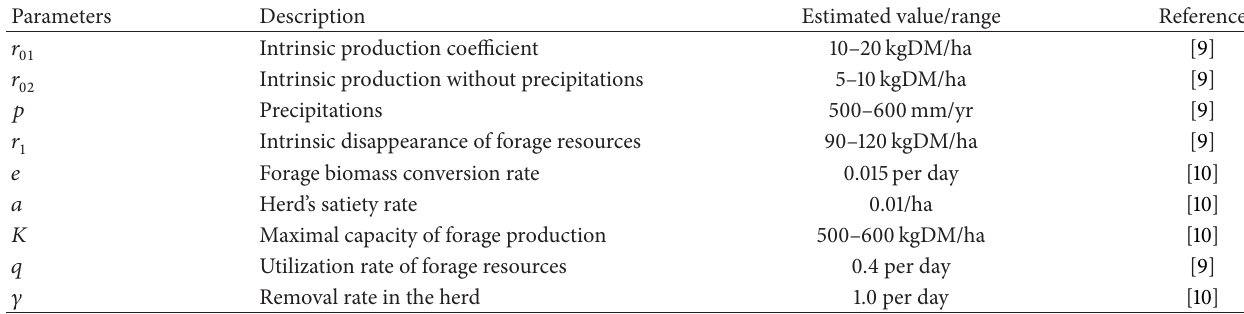
Table 1: Parameter values for transhumance in System (1).